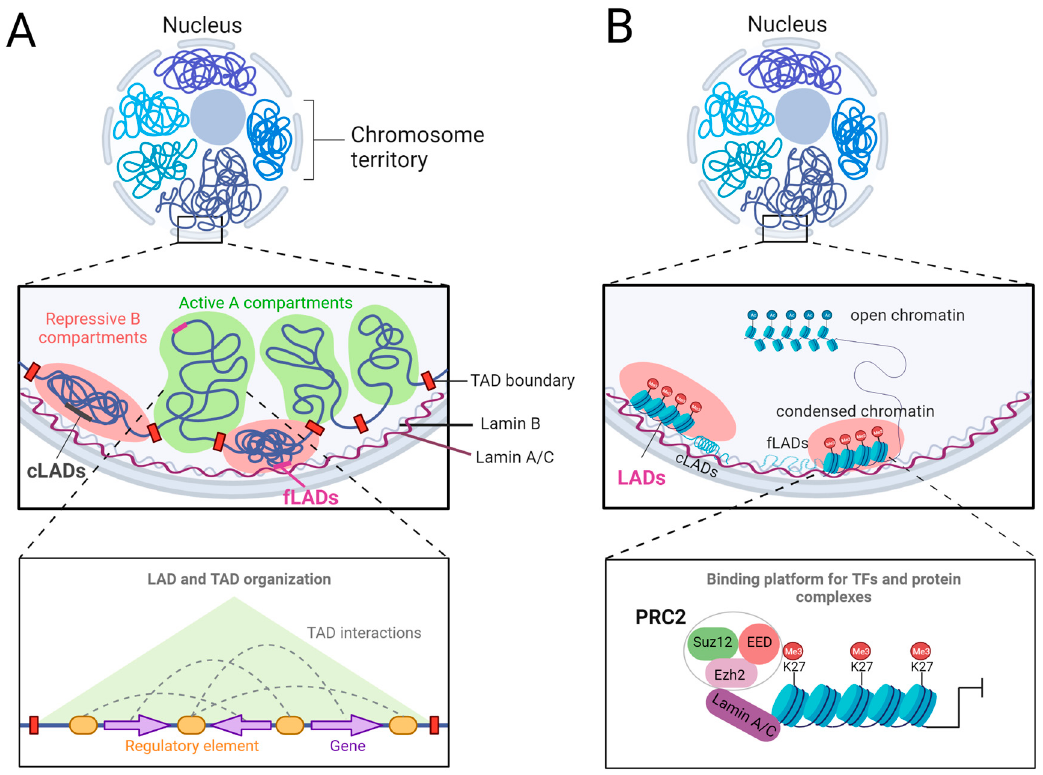
Figure 3. Lamin-A/C-mediated chromatin organization. ( A ) Nuclear lamins play a key role in shaping the 3D chromatin organization by anchoring chromatin at the nuclear periphery. Mutations in LMNA might cause changes in LAD and TAD organization, leading to aberrant transcriptional programs. A- and B-type lamins form interconnected networks; thus, LMNA mutations might alter lamin B function. ( B ) The nuclear lamina serves as a binding platform of TFs and chromatin modifiers, for example, the PRC2 complex, which might be altered upon LMNA mutations.